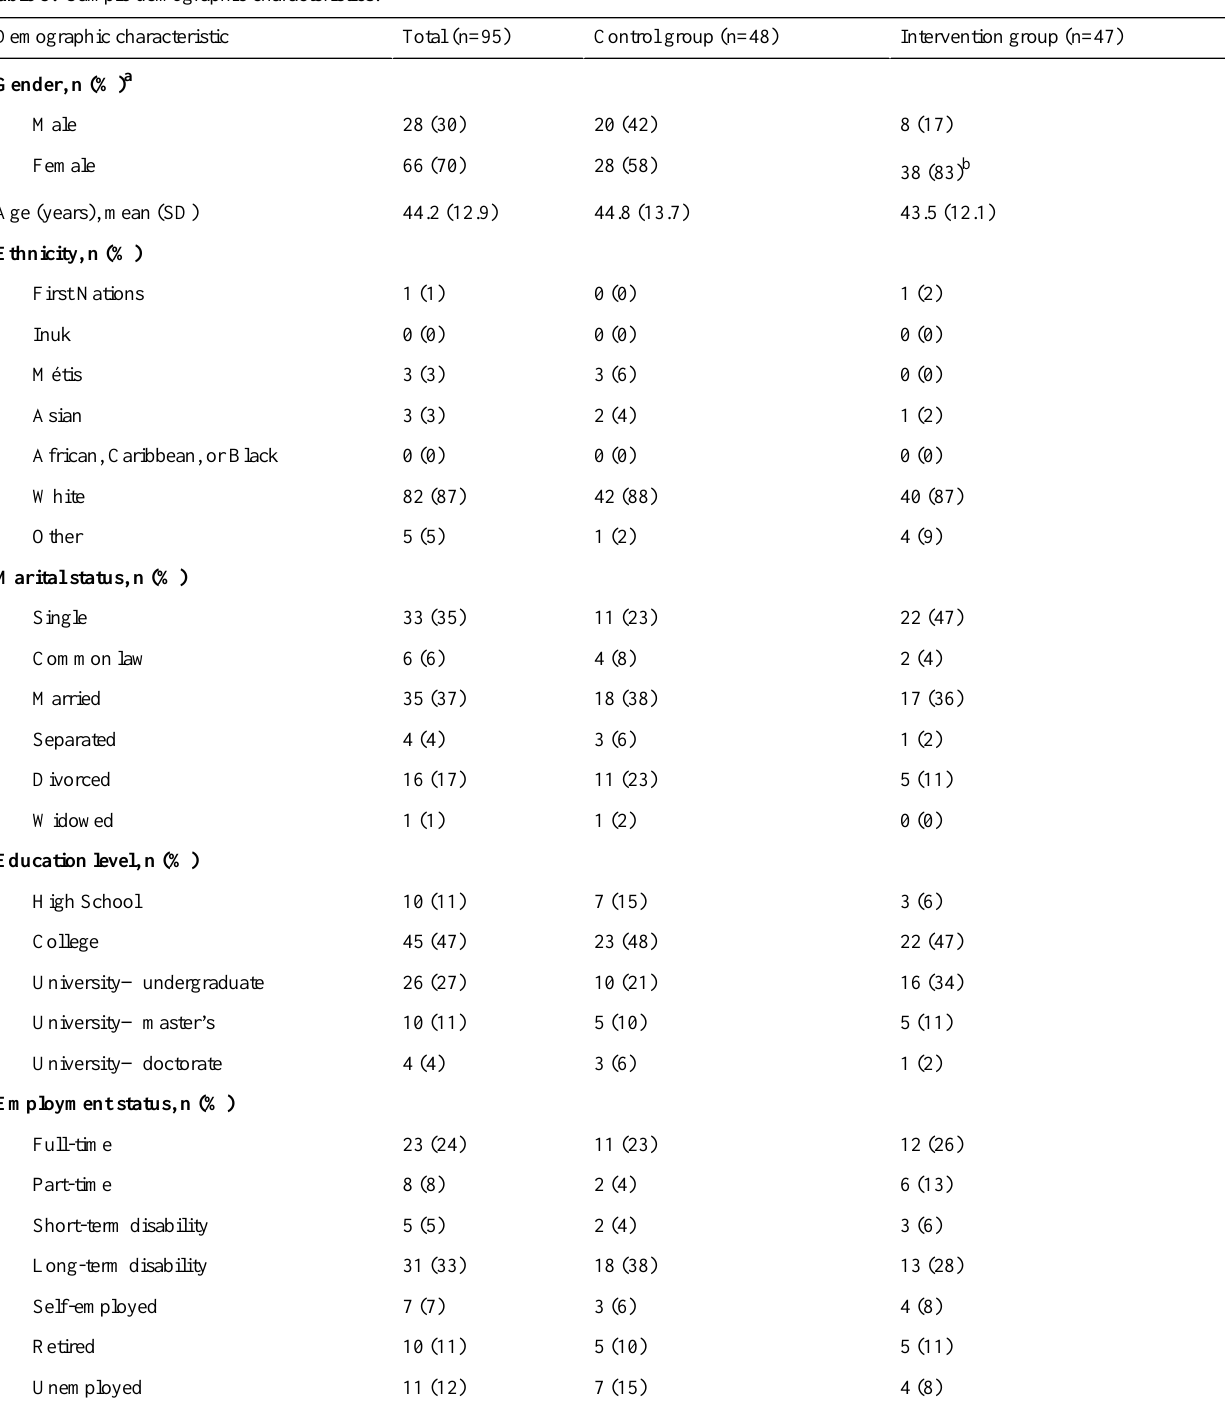
Table 5. Sample demographic